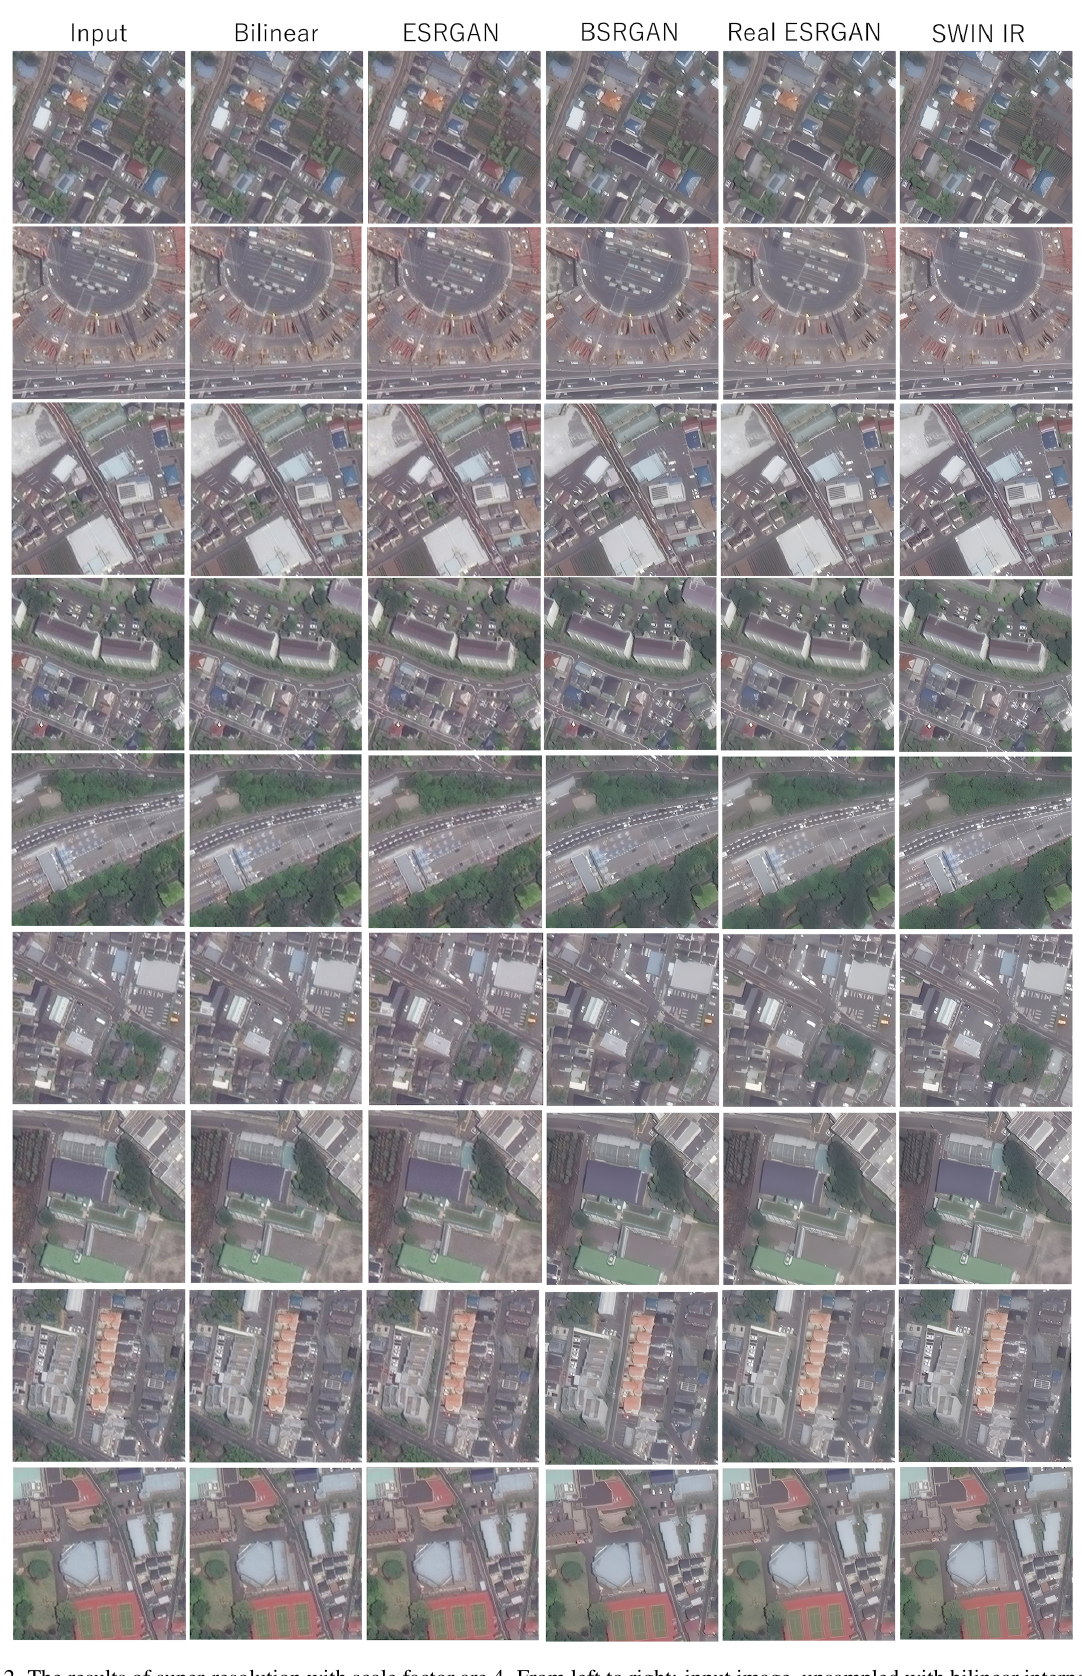
Figure 2. The results of super-resolution with scale factor are 4. From left to right: input image, upsampled with bilinear interpolation, ESRGAN (Wang et al., 2018), BSRGAN (Zhang et al., 2021), Real ESRGAN (Wang et al., 2021a), SWIN IR (Liang et al., 2021). BSRGAN, Real ESRGAN, SWIN IR are Real World SR methods. The images are obtained WorldView-2 sensor from MAXAR.